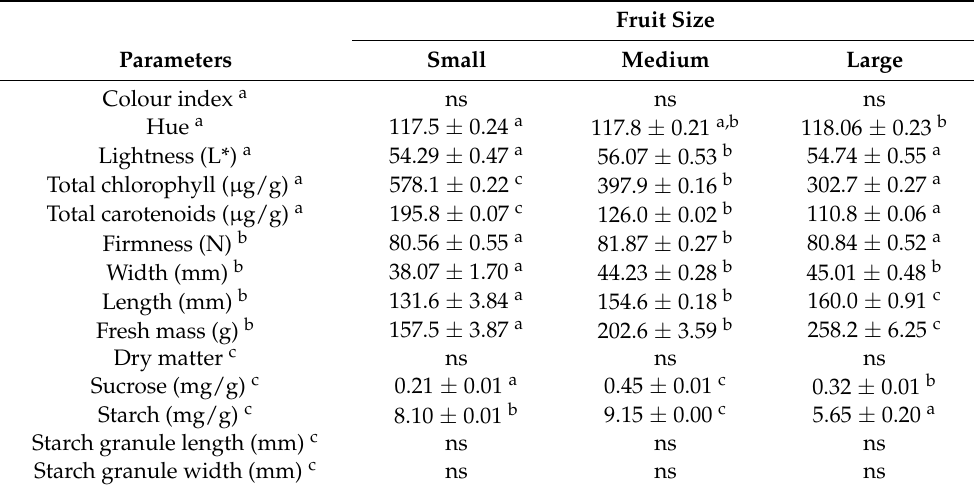
Table 1. Effect of banana fruit size on maturity parameters.